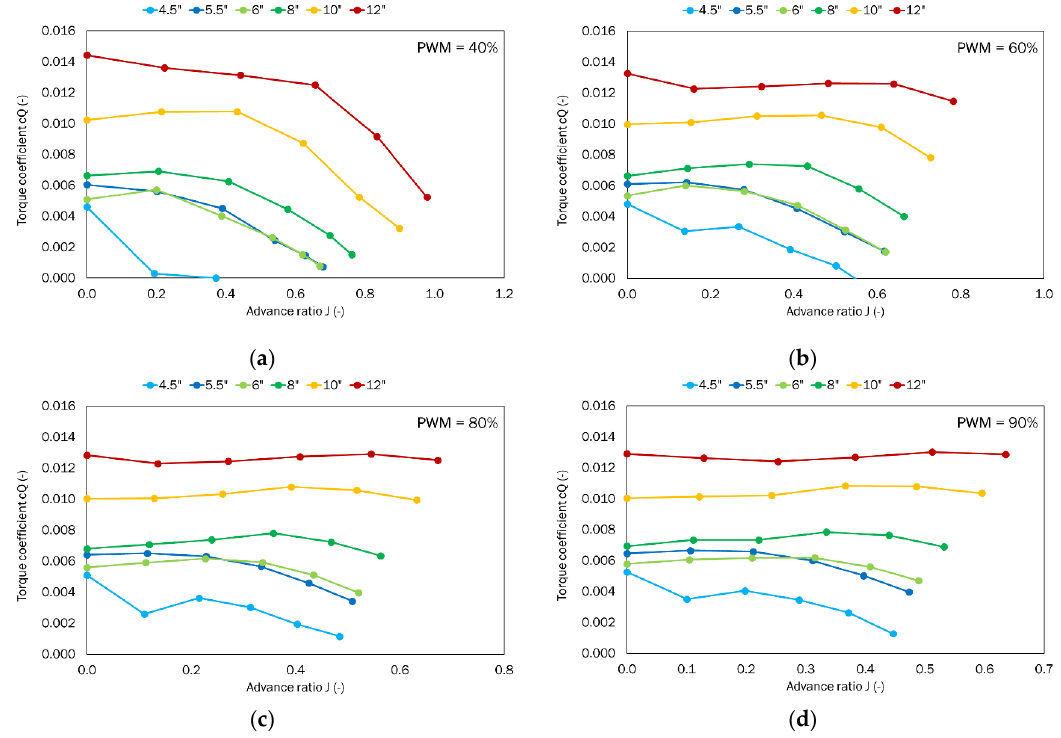
Figure 10. Torque coefficient as a function of the advance ratio for the tested set of propellers for the defined PWM values: ( a ) 40%; ( b ) 60%; ( c ) 80%; ( d )